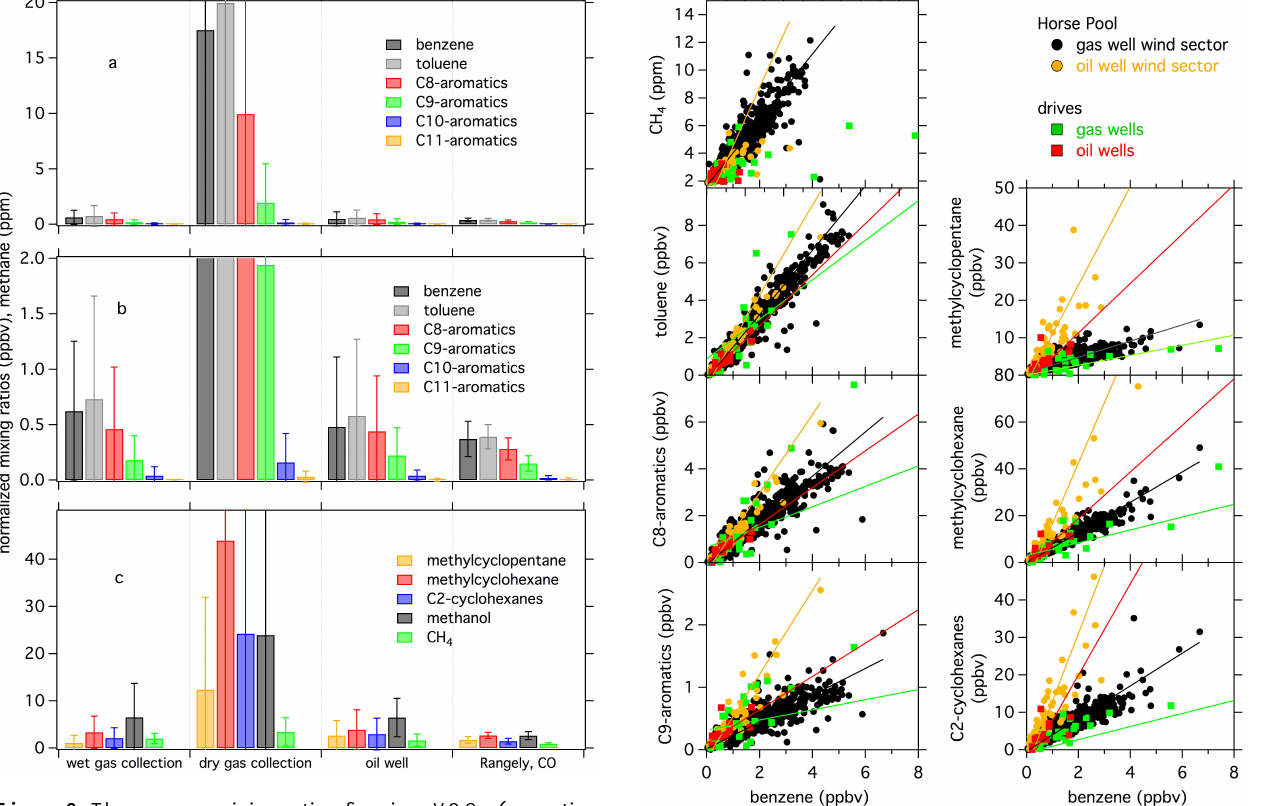
Figure 9. The average mixing ratio of various VOCs (aromatics, cycloalkanes, methanol and methane) close to emission sources in the Uintah basin are averaged for each category of point sources. The error bars indicate the standard deviation. All average mixing ratios next to the emission sources are normalized to an average 2ms − 1 wind speed.